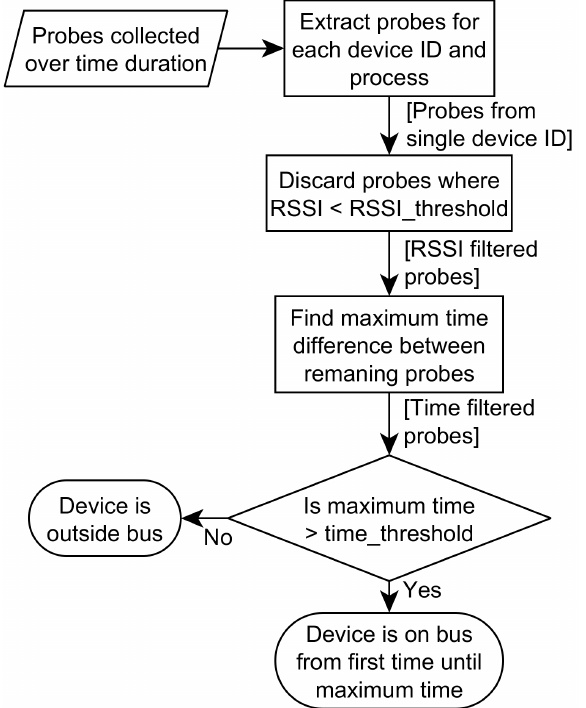
Figure 2. Flow of the WLAN estimator algorithm showing how WLAN probes are processed by applying the two-threshold filtering in order to decide whether the device is on the bus or